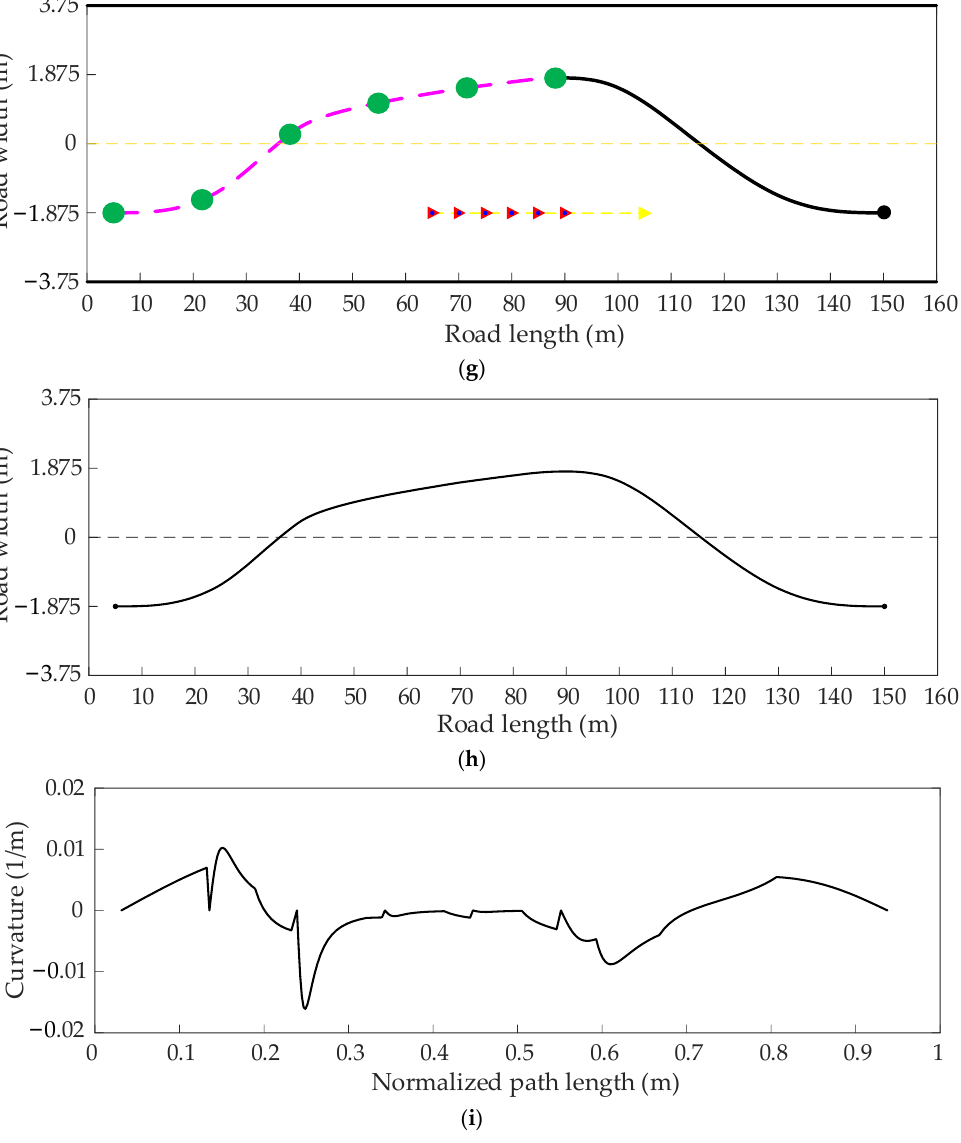
Figure 17. The path planning results in a dynamic scenario with driving in the same direction. ( a ) The planned path in the first frame. ( b ) The planned path in the second frame. ( c ) The planned path in the third frame. ( d ) The planned path in the fourth frame. ( e ) The planned path in the fifth frame. ( f ) The planned path in the sixth frame. ( g ) The path coherence process of six frames. ( h ) The coherence path of six frames. ( i ) The curvature of the coherence path.